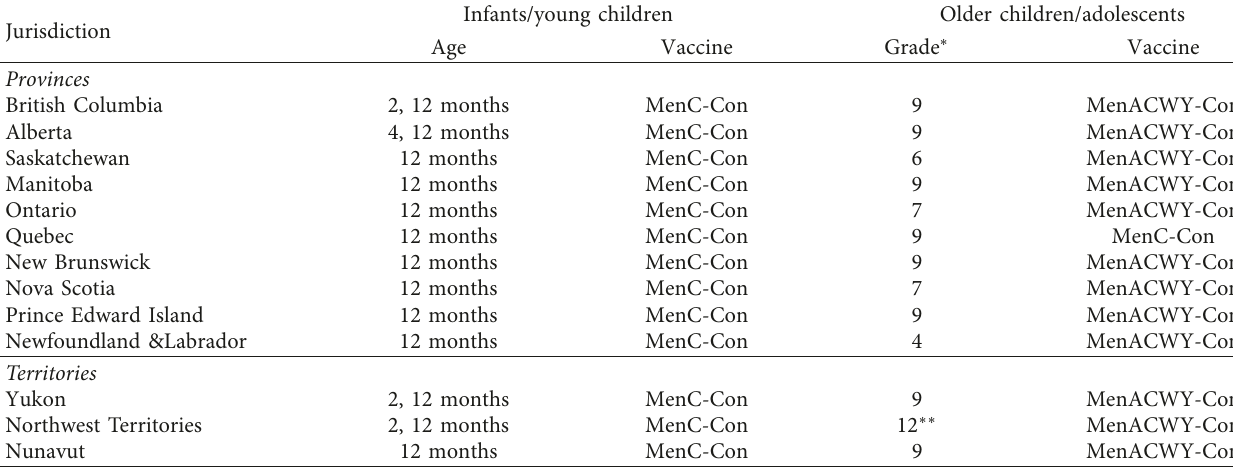
Table 2: Routine immunization programs for children and adolescents (school-based programs) in Canadian provinces and territories (as of August 31,